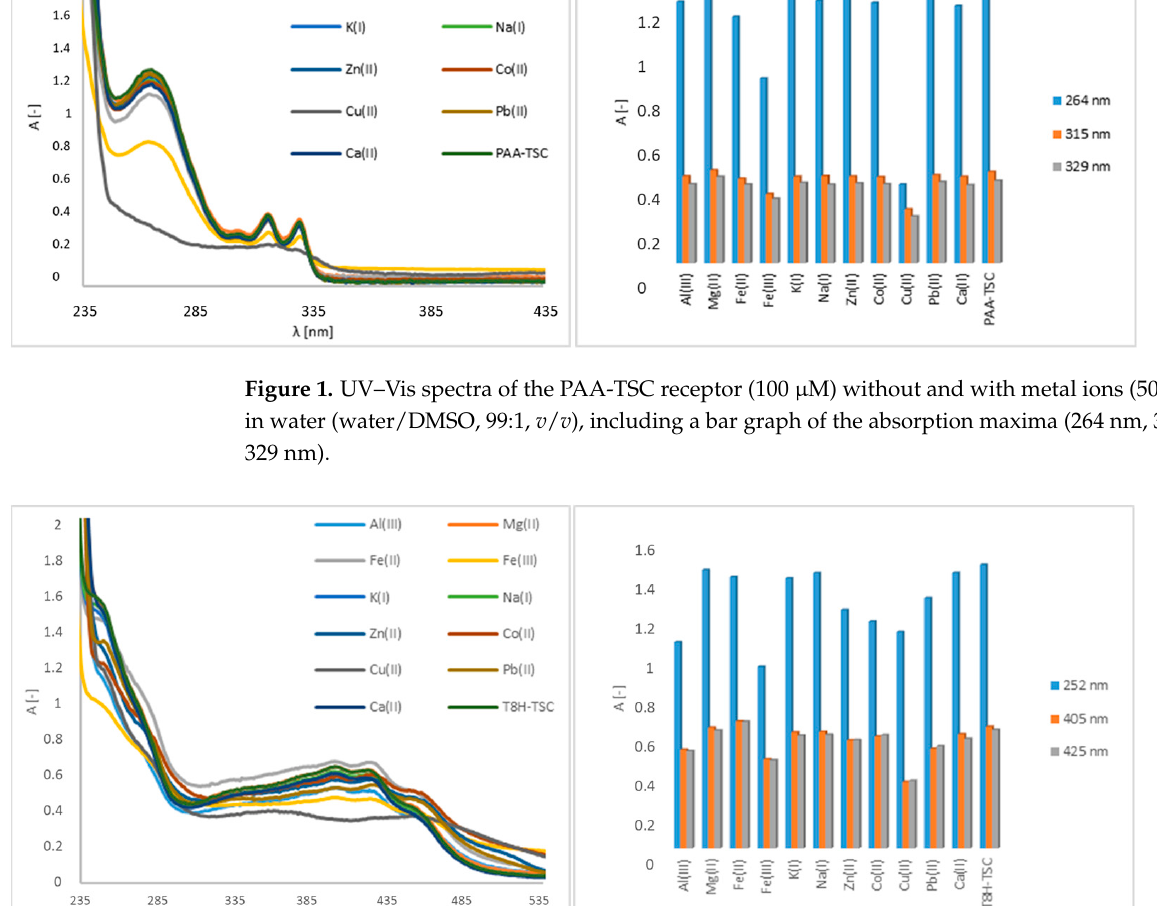
Figure 3. Titration and titration curves of the PAA-TSC receptor with Cu(II) ions in water (wa- ter/DMSO, 99:1, v / v ). Titration curves were measured at the absorption maxima (265 nm, 315 nm, 329 nm) of the PAA-TSC receptor. The Ka values of the receptor complexes (PAA-TSC, T8H-TSC) with transition metal ions (Cu(II), Fe(III) and Fe(II)) were calculated in Letagrop Spefo 2005, and the Ka values and stoichiometry are shown in Table 2. In the case of the PAA-TSC receptor, the Cu(II) ion shows the highest affinity, and in the case of the T8H-TSC receptor, the Fe(III) ion exhibits the highest affinity. Therefore, this suggests that the receptors we synthesized can be used as chelators for copper and iron ions. Table 2. Ka values and stoichiometry of receptors (PAA-TSC, T8H-TSC) in complex with metals (Cu(II), Fe(III), Fe(II)) in water (water/DMSO, 99:1, v / v ). Receptor Ion Log (K 1 )